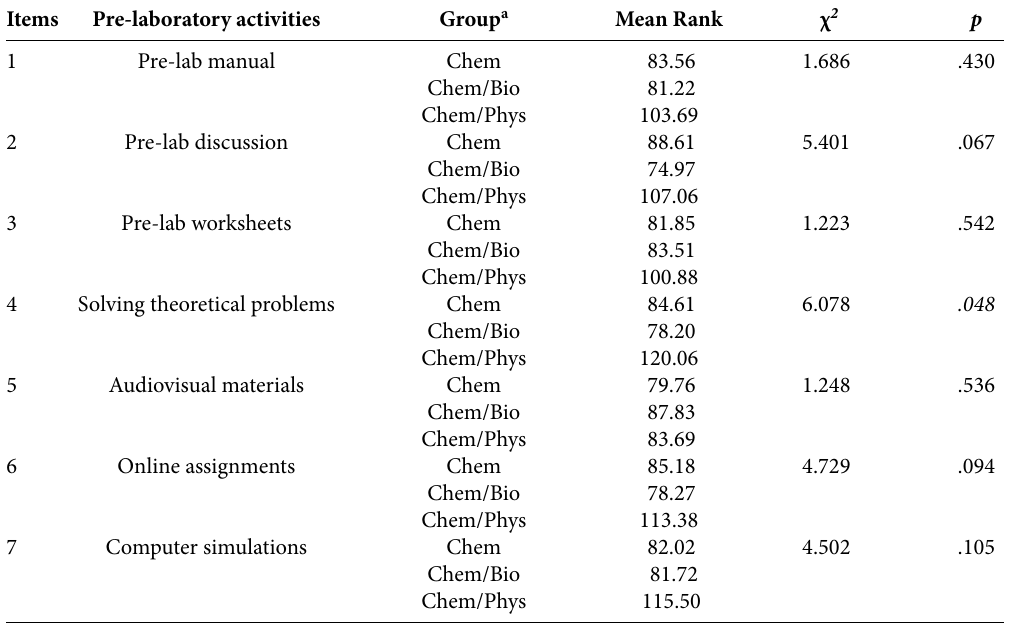
Table 3. The results of the Kruskal–Wallis H test of statistically significant differences in the chemistry